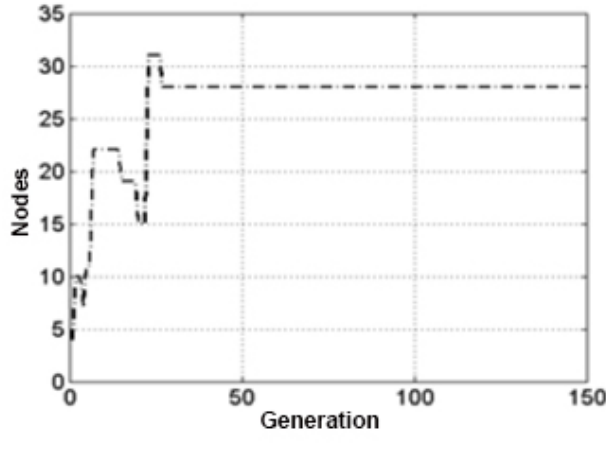
Figure 5. Model size cryotherapy problem